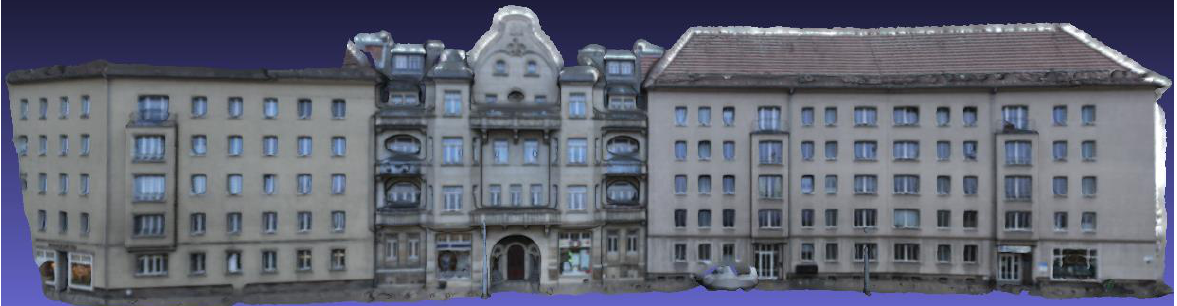
Figure 2. 3D mesh generated from RGB image